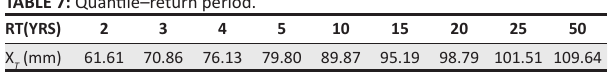
TABLE 7: Quantile–return period.